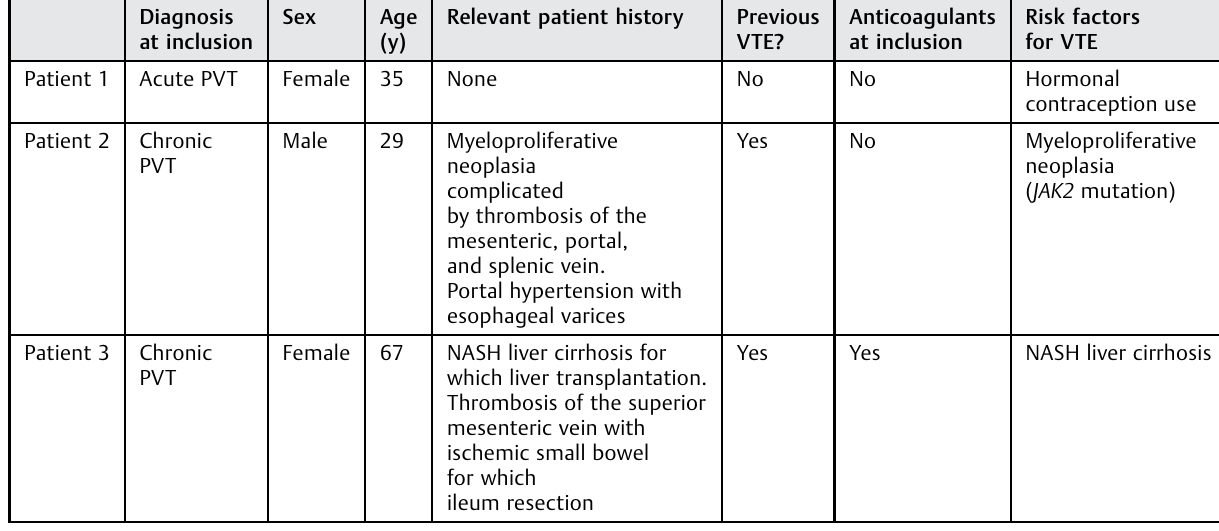
Table 2 Patient characteristics of the three patients diagnosed with